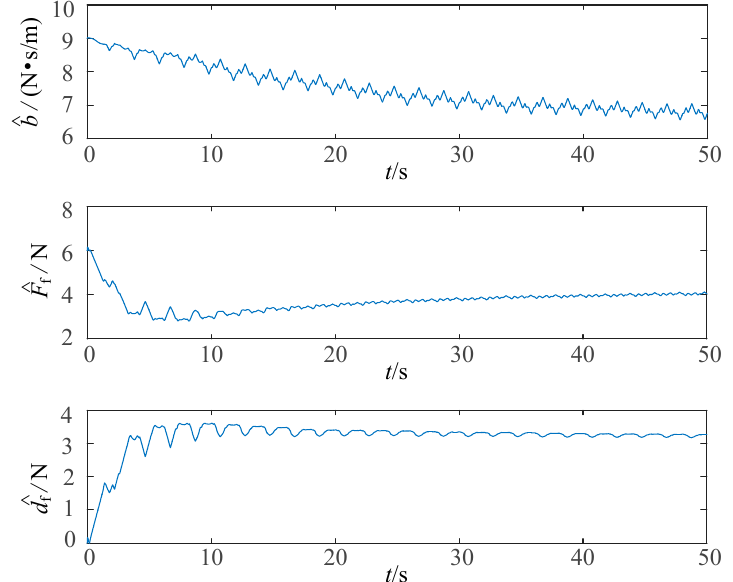
Figure 7. Parameter and disturbance estimations of the proposed controller when the reference is a 0.5 Hz sinusoidal trajectory.